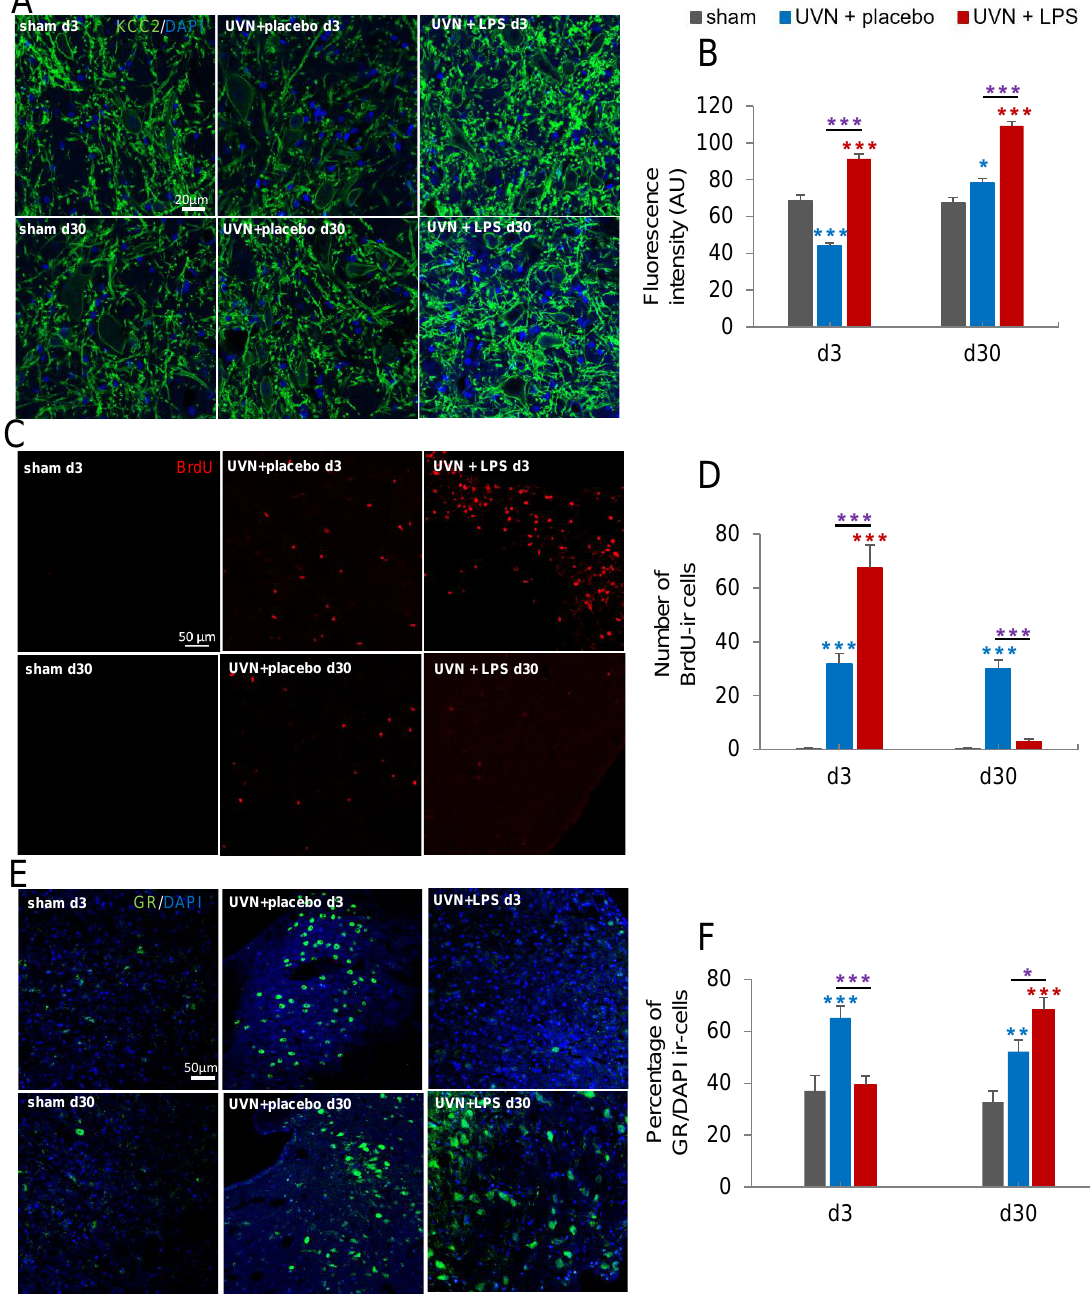
Figure 4. The expression of adaptative postlesional plasticity in the deafferented vestibular nuclei (VN) is altered following acute LPS treatment. ( A ) Confocal visualization of KCC2 and DAPI (nucleus) stainings in the left lateral vestibular nuclei (LVN) of a representative animal in sham, UVN+placebo, and UVN+LPS groups at d3 and d30. ( B ) Quantification of KCC2 fluorescence intensity at neuronal membrane in the left LVN at d3 and d30. ( C ) Confocal visualization of BrdU staining in the left